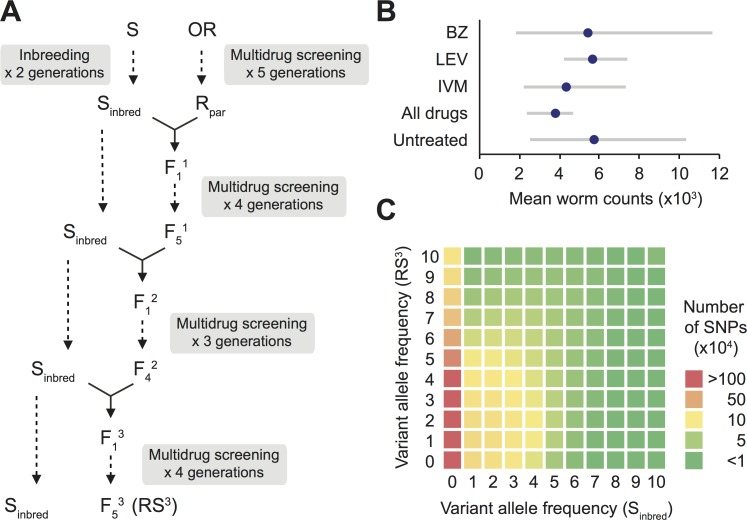
Generation of mapping populations in Teladorsagia circumcincta.(A) Introgressing field-derived multiple-anthelmintic resistance alleles into an inbred anthelmintic susceptible genetic background. Oxfendazole (BZ), levamisole (LEV) and ivermectin (IVM) were used for multidrug screening. (B) Efficacies of BZ, LEV and IVM against the multiple-anthelmintic resistant Rpar strain of T. circumcincta in goat kids. Back-transformed square-root mean worm counts were presented with range of actual counts. No statistically significant worm count differences were detected between any of the groups (Wilcoxon rank-sum test, n = 6 for each treatment group). (C) Two-dimensional variant allele frequency spectra for Sinbred and RS3
T. circumcincta populations. Both horizontal and vertical axes are in units of 10%. Bi-allelic SNPs were used after subsampling to a uniform coverage of 10× for both strains because differences in mean sequencing depths could lead to a systematic bias in polymorphism detection sensitivity.